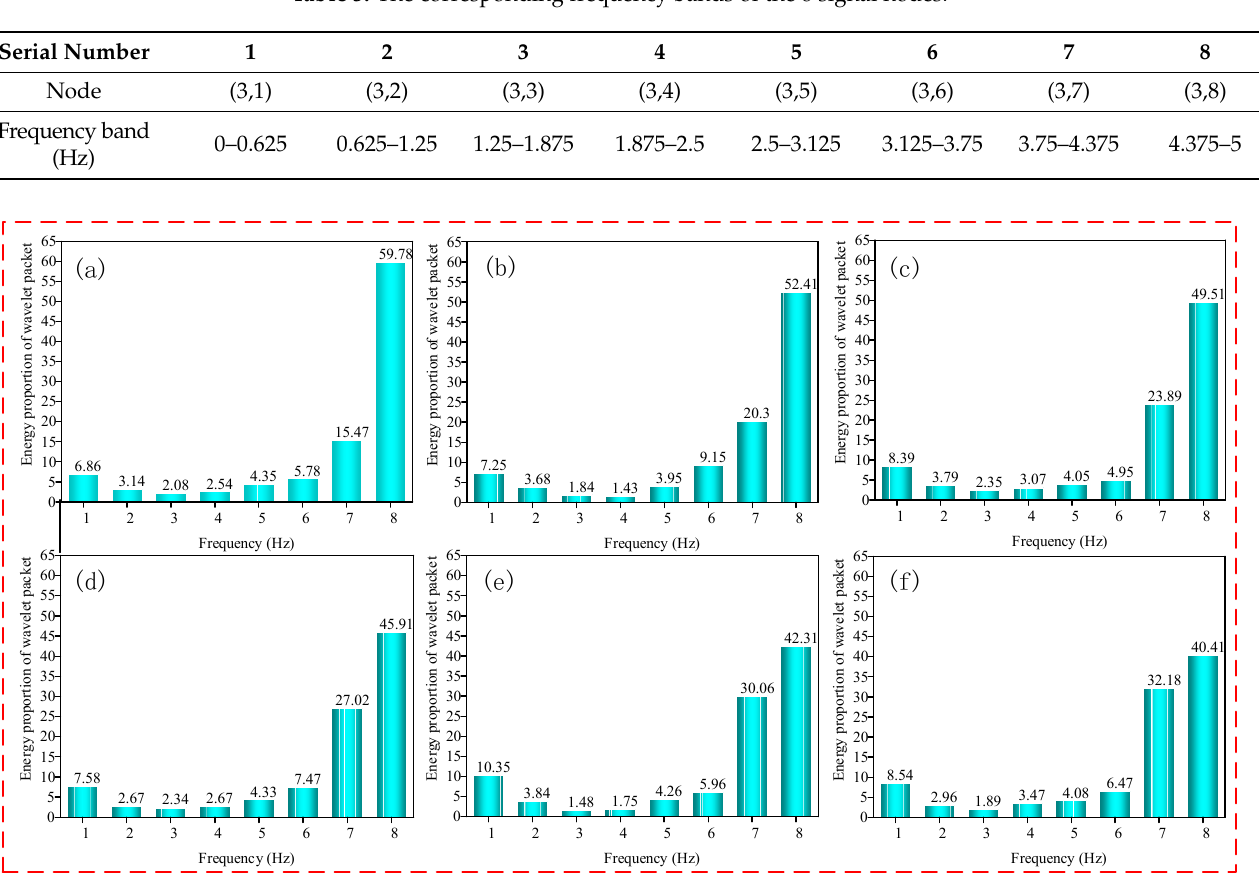
Table 3. The corresponding frequency bands of the 8 signal nodes.